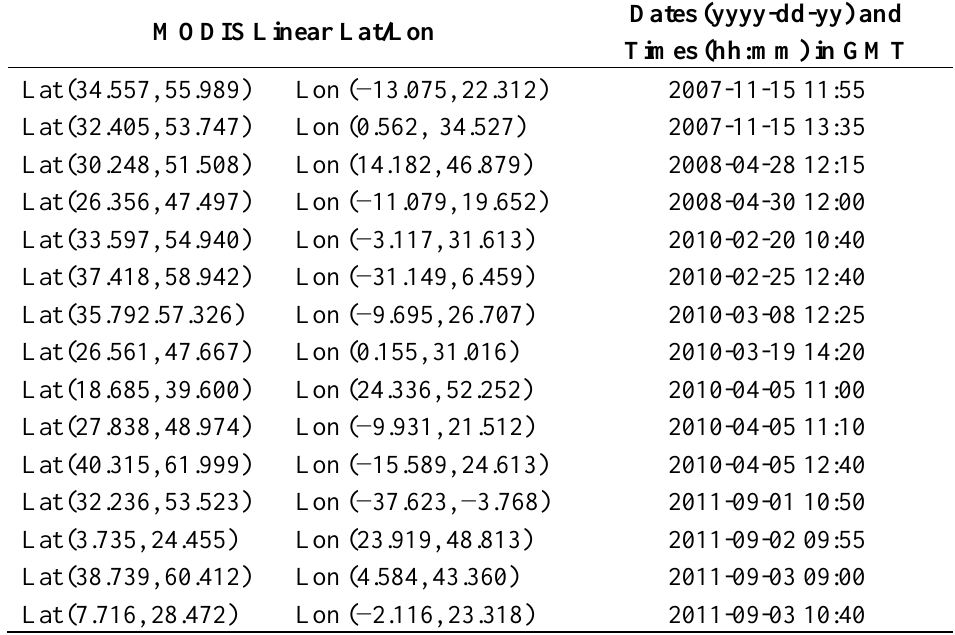
Table 3. List of MYD04/MOD04 data used for the validation of dust aerosol